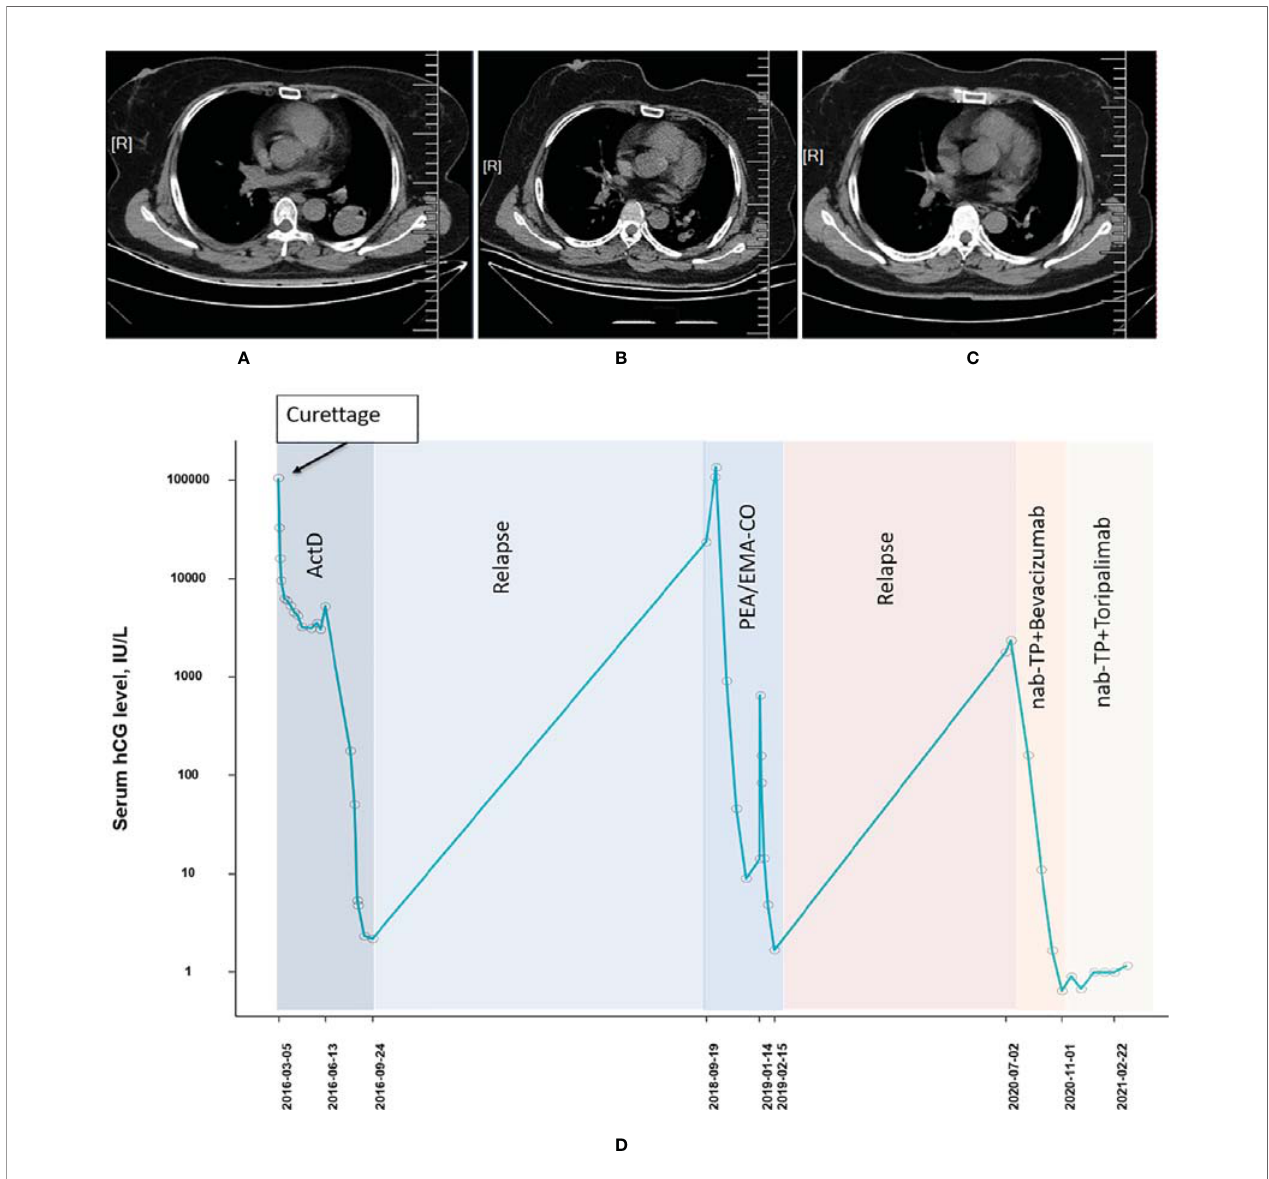
FIGURE 3 | Computed tomography imaging (A) before pulmonary metastasis, (B) before combined treatment of PD-1 and chemotherapies, and (C) after combined treatment of PD-1 and chemotherapies (patient 3). (D) The concentration of the b -hcg level since the diagnosis of choriocarcinoma (patient